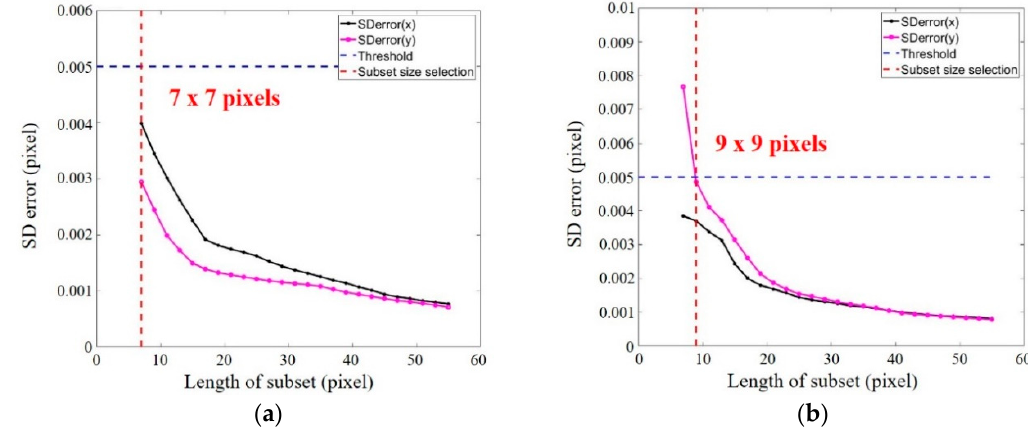
Figure 6. Determination of subset sizes using subset intensity gradient (SSSIG) at the randomly selected two different seed points: ( a ) seed point 1 and ( b ) seed point 2.